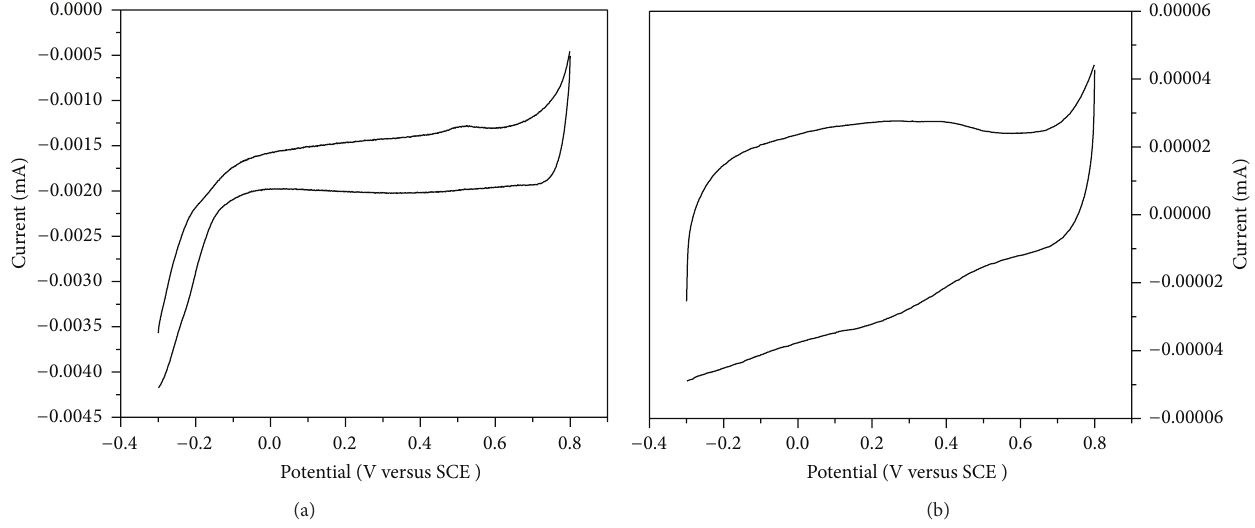
Figure 3: Voltammetric responses of bare gold (Au) electrode in different electrolytes: (a) 0.1M HCl and (b) 0.01M HCl, respectively (scan rate = 50mVs −1